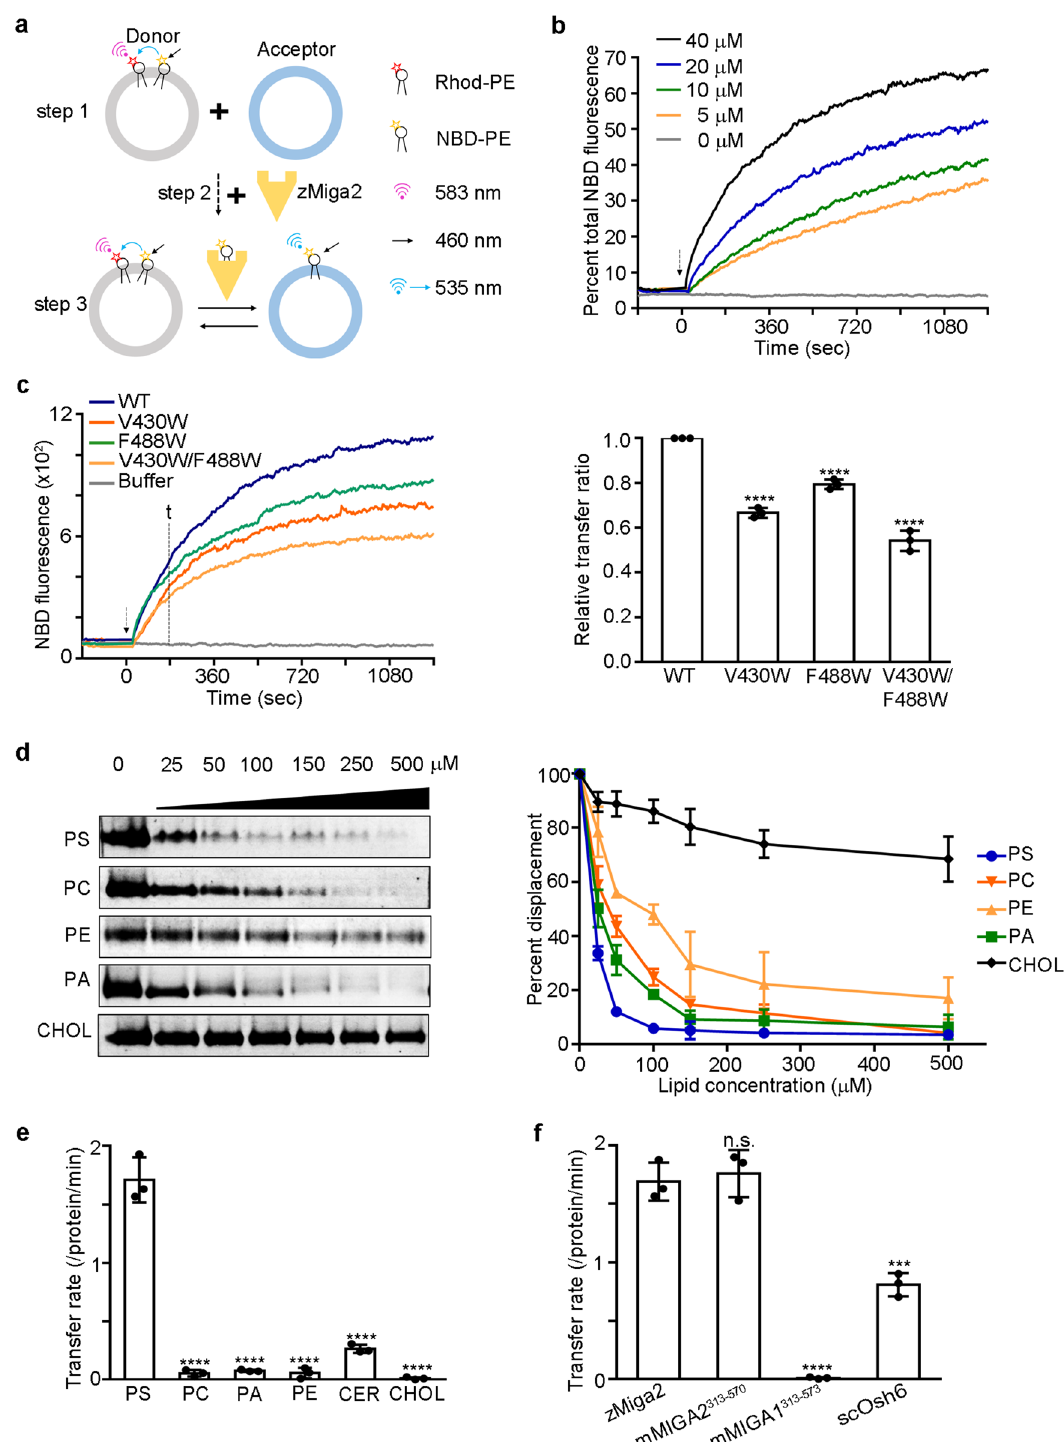
Next, we examined how anchoring of MIGA2 and VAPB in